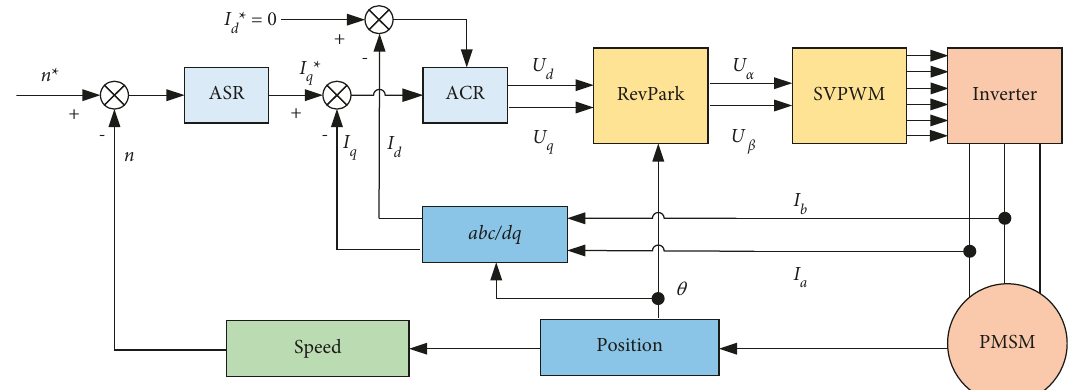
Figure 4: Control loop of the PMSM corresponding to the MSK signal.